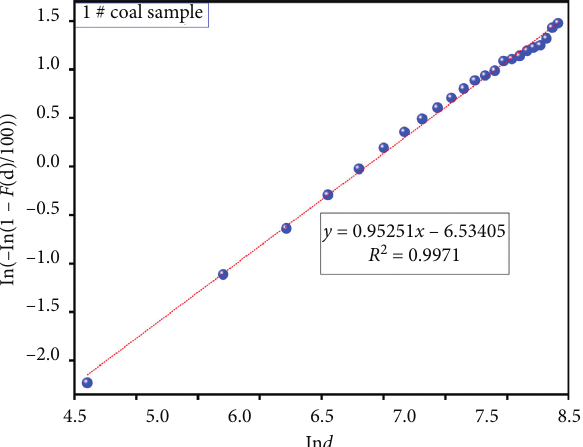
Figure 10: Cumulative particle size distribution and fitting results for 1 # coal sample after the